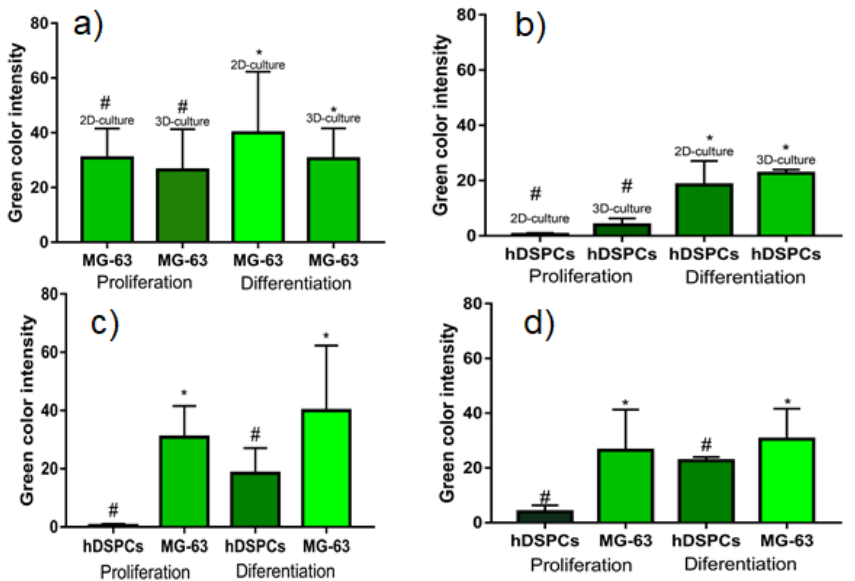
Figure 14. OCN expression with comparisons between the same cell line on 2D ( a ) and 3D ( b ) surfaces. OCN expression with comparisons between the same cell line (MG-63) ( c ) and (hDPSCs) ( d ) in different culture media # and * when p < 0.05.